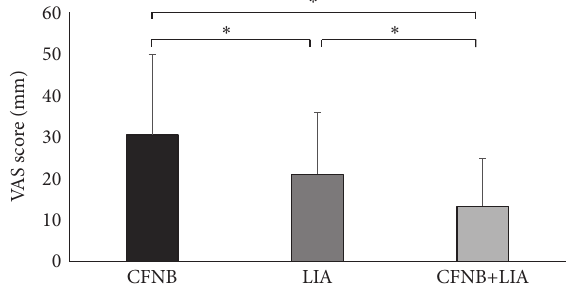
Figure 1: Visual analog scale (VAS) for pain at rest 24 hours post- operatively. Significant differences are seen among groups 24 hours after surgery. Data are presented as mean ± SD. CFNB, continuous femoral nerve block; LIA, local infiltration analgesia. ∗ indicates 𝑝 < 0.05